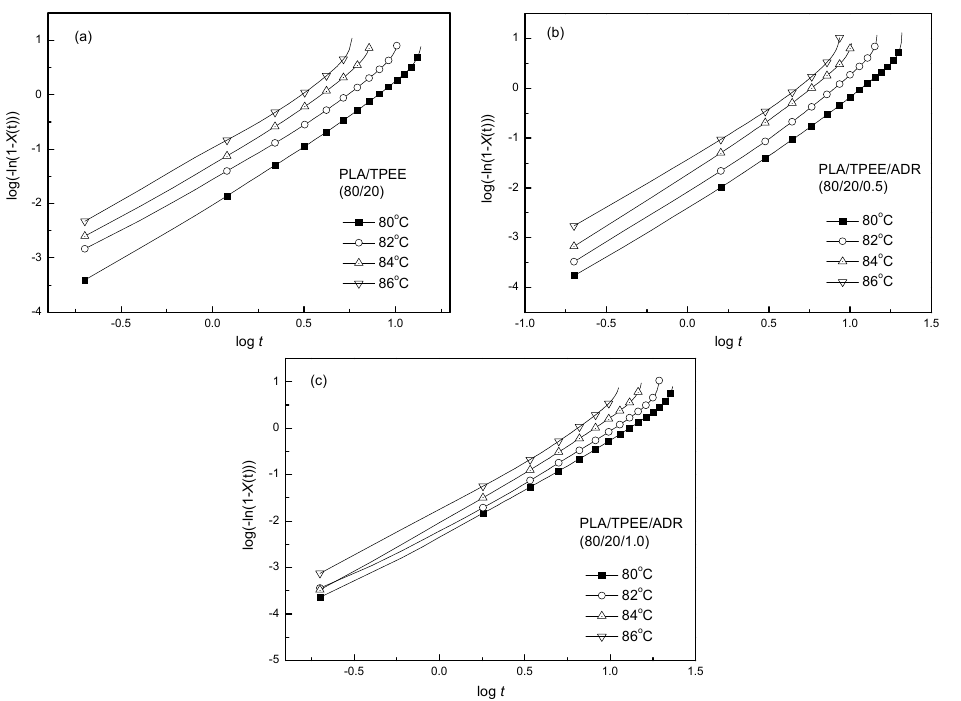
Figure 2. Plots of log[ − ln(1 − X (t))] vs. log t of the representative samples isothermally crystallized at the predetermined temperatures: ( a ) PLA/TPEE (80/20); ( b ) PLA/TPEE/ADR (80/20/0.5); ( c ) PLA/TPEE/ADR (80/20/1.0).